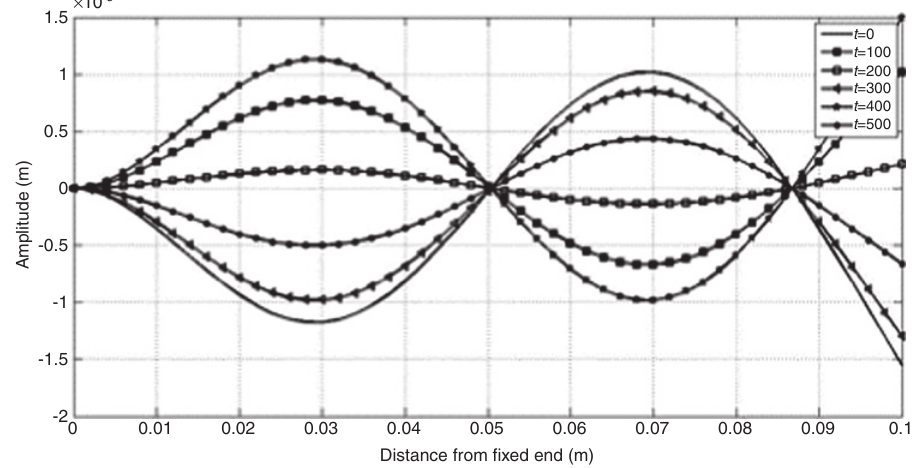
Figure 11: Vibrations of the third characteristic mode of the cantilever beam. Time, t , is in